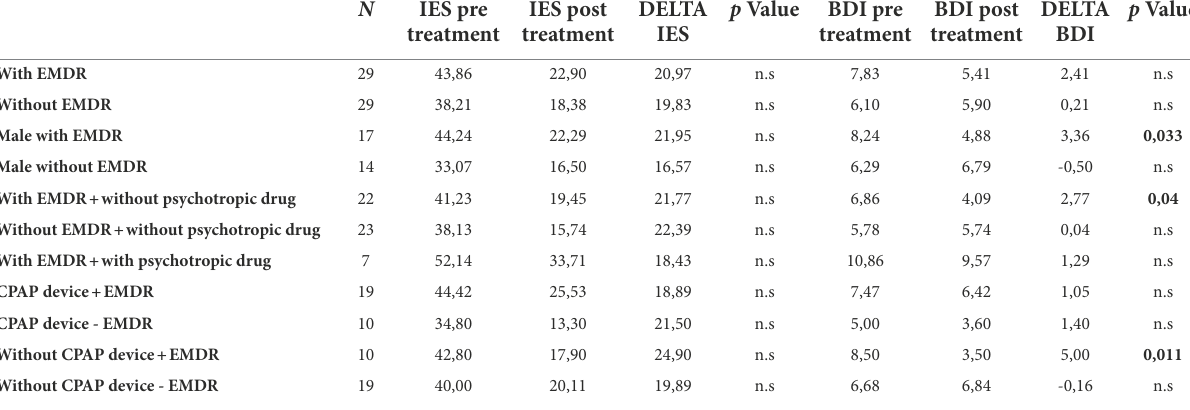
TABLE 4 Averages values of IES-R and BDI scores of patients agreed psychological and EMDR treatment with/without use of psychotropic drug.